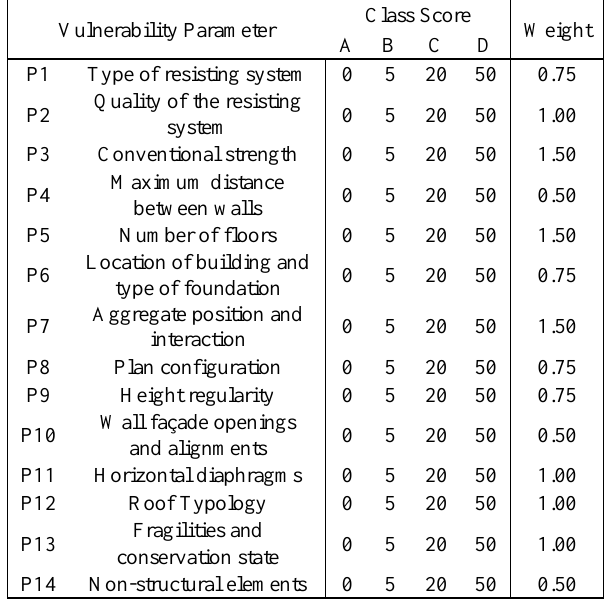
Table 5. Structure of the Vicente Method (Vicente et al., 2011). The average seismic vulnerability index is 41, with a Standard Deviation (SD) of 11. More in details, the application of the method shows a medium seismic vulnerability of the masonry aggregates in the historic centre of Campi Alto di Norcia, with I V index in the range 10 – 20 for the 4% of the buildings, and 20 – 30 for the 12% of the buildings, between 30 and 40 for the 30% and between 40 and 50 for 35% of the SUs analysed. Remaining SUs present higher vulnerability indexes (Figure